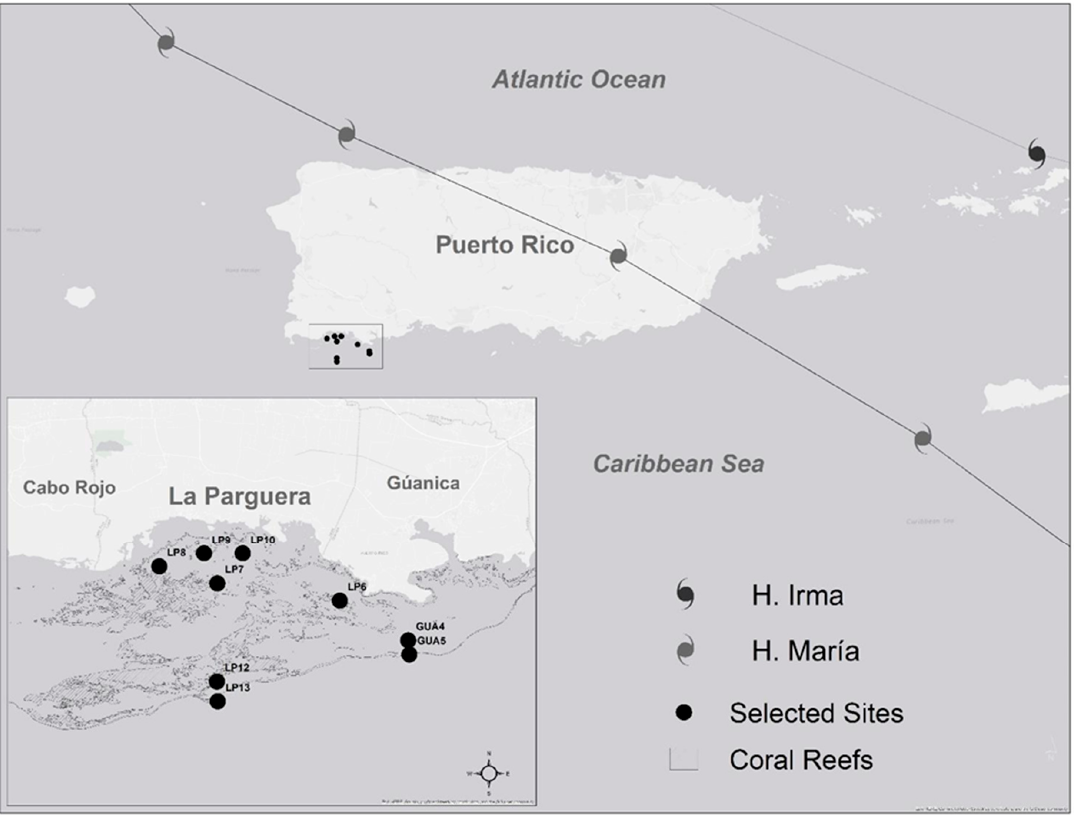
Figure 1. Study area at southwestern Puerto Rico with Hurricanes Irma and María paths. Sampling sites and delimited areas represent submerged coral reef areas that support fisheries and economies around the region. Base map was from ESRI ® .